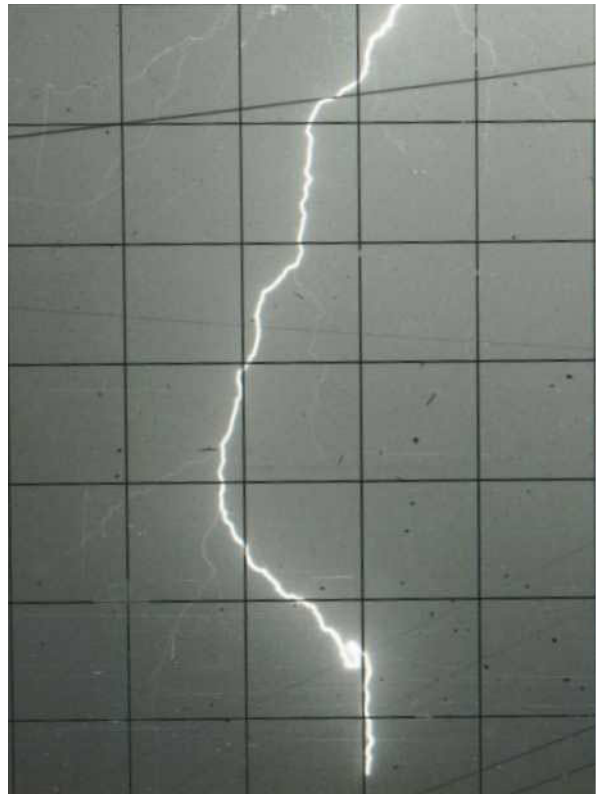
Fig. 3. Example of a photographic record of a downward flash ob- served at MC.